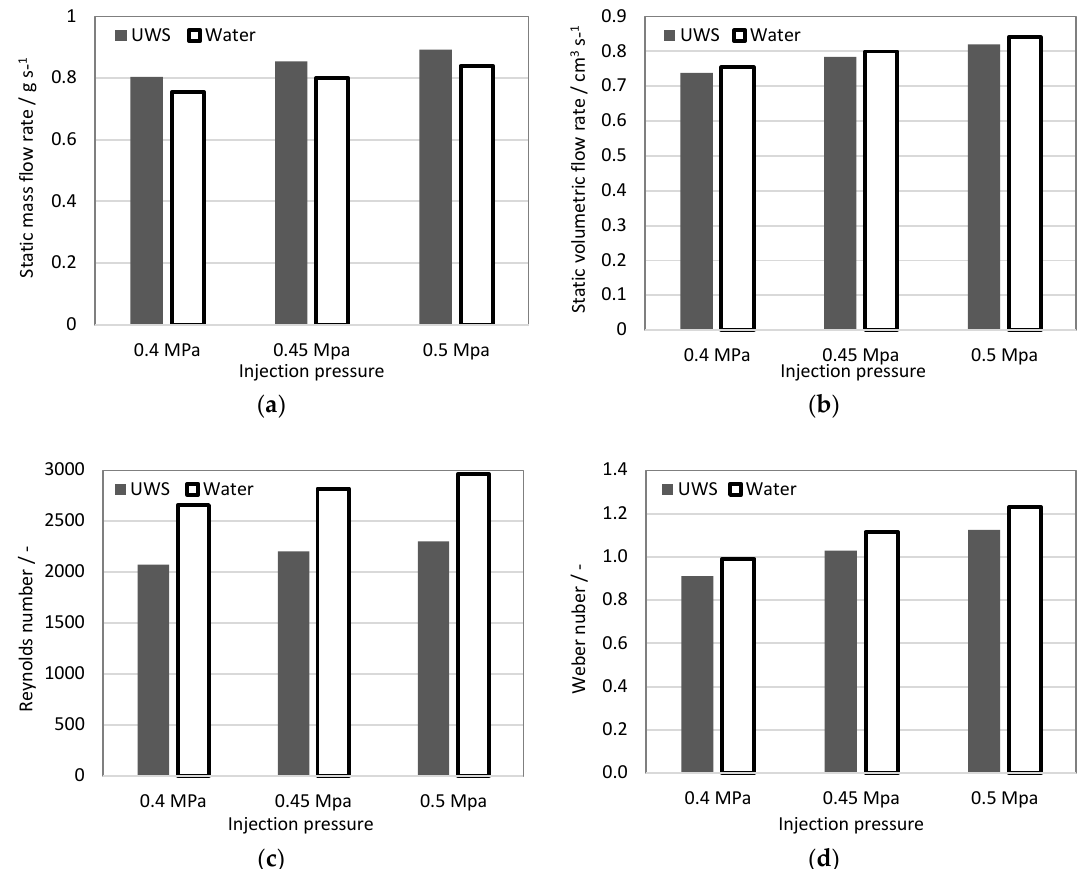
Figure 2. In-injector flow characteristics: ( a ) static mass flow rate; ( b ) static volumetric flow rate; ( c ) Reynolds number; ( d ) Weber number (referred to gas).